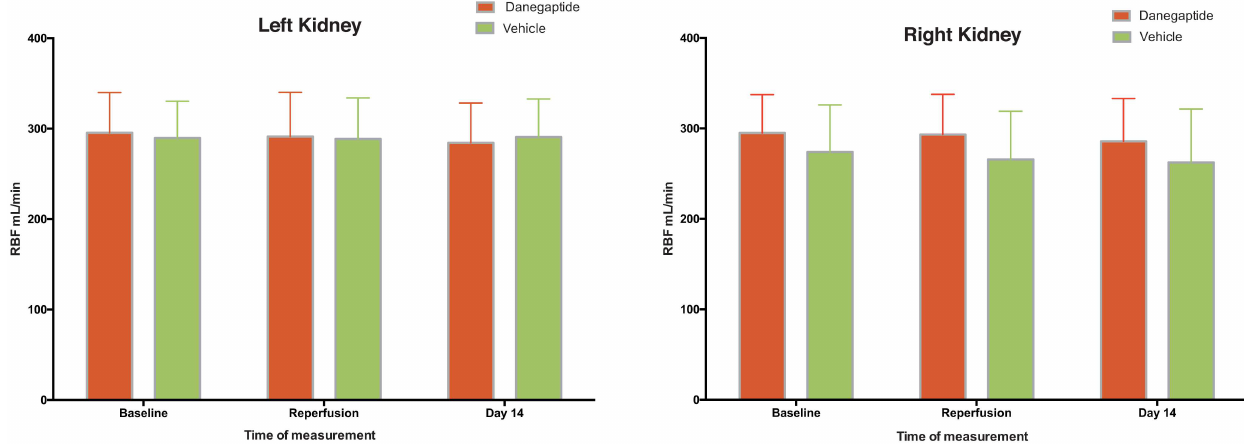
Fig 4. Renal Blood Flow— RBF measured by MRI at baseline,after reperfusionand 14 days after I/R-I. Error bars represents 95% CI.